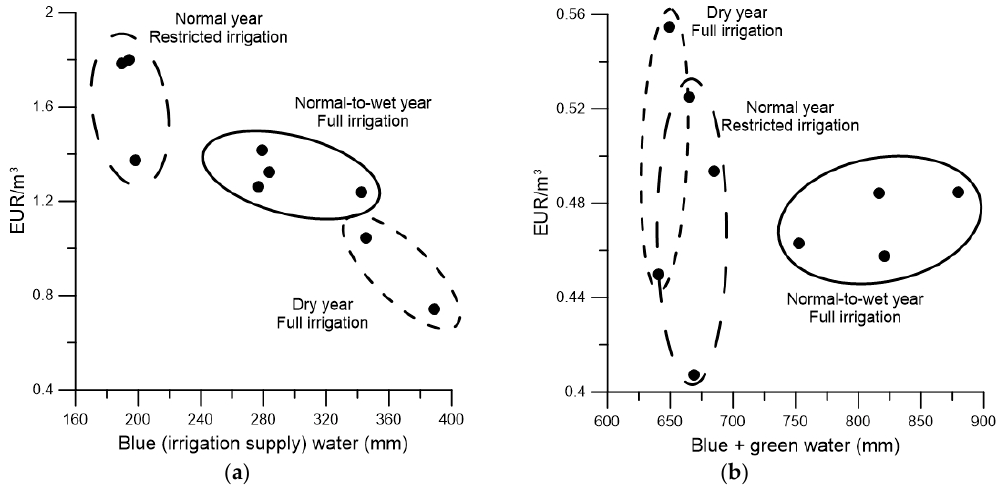
Figure 4. Water productivity in irrigated agriculture (EUR/m 3 base 2012) and water consumed (mm). ( a ) Water productivity blue water; ( b ) Water productivity blue + green water.